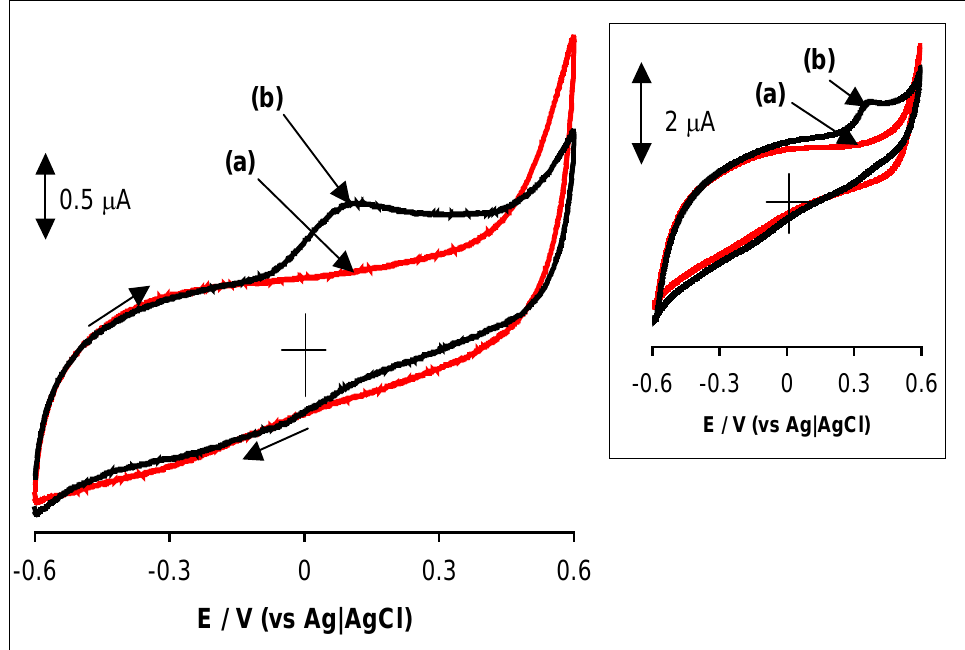
in 0.2 M NaOH 4